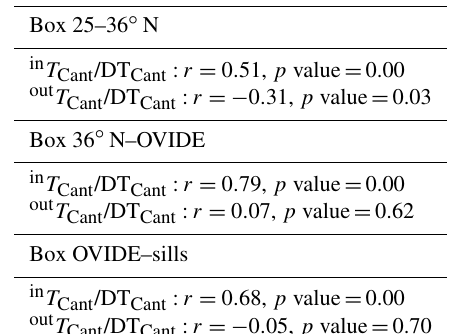
Table 7. Correlation coefficient ( r ) and p value between the di- vergence of Cant transport (DT Cant ) and the incoming (in) or outgoing (out) transport of Cant ( T Cant ) for the three boxes, 25—36 ◦ N, 36 ◦ N–OVIDE and OVIDE–sills, over the period 1959– 2011. DT Cant = incoming – outgoing Cant fluxes across the bound- aries of boxes. The linear trend was removed from each times series beforehand.